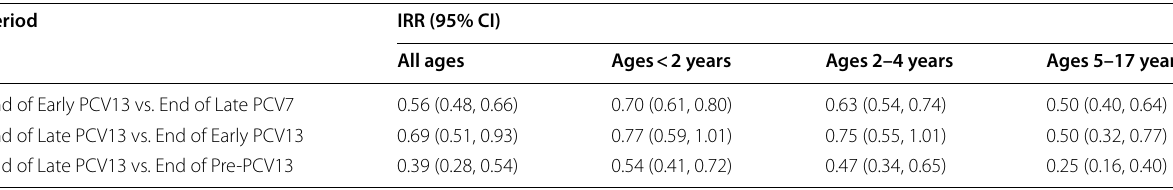
Table 5 Estimated changes in ACP IRs at the end of each PCV study period compared to the prior period and the pre‑PCV7 period among Medicaid‑insured children aged 0–17 years (2001–2018)